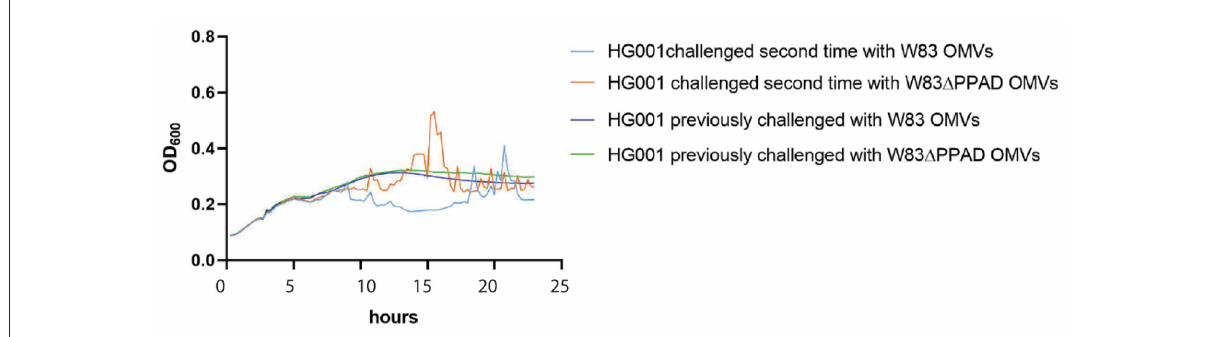
FIGURE4 OMV-mediated aggregation of S. aureus is a reversible phenotype. S. aureus HG001 was exposed to OMVs of P. gingivalis W83 or W83 1 PPAD OMVs. The aggregated bacteria were collected and re-cultured in fresh RPMI medium with or without the addition of OMVs after 5h of